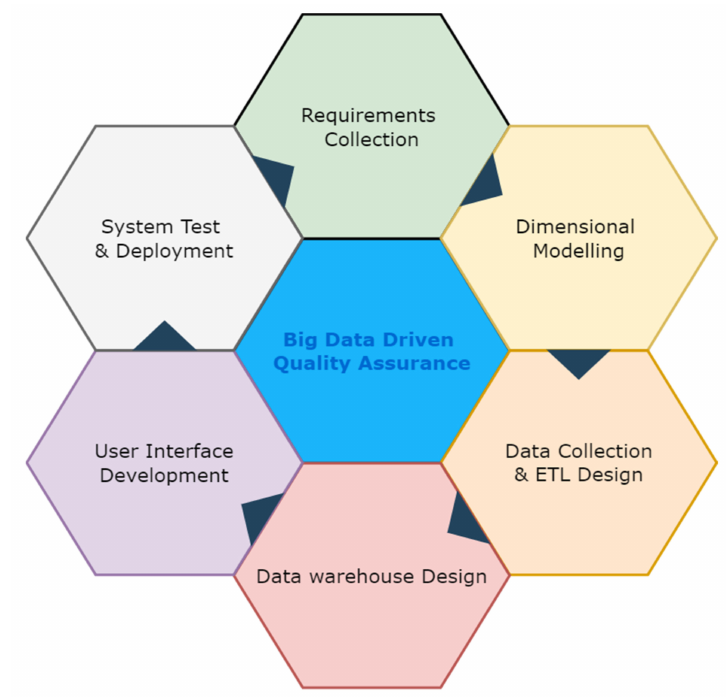
Figure 7. Data warehouse development lifecycle.